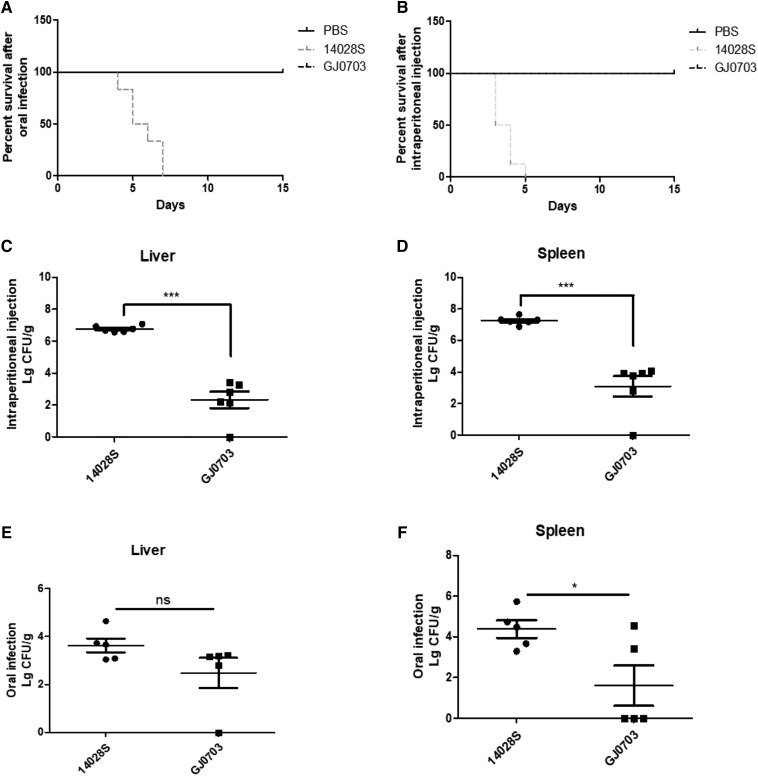
Rissen strain GJ0703 is hypovirulent in mice and causes an attenuated systemic infection. The survival of mice infected by oral gavage (A) or intraperitoneal injection (B). Bacterial burdens in livers (C) and spleens (D) of mice infected by intraperitoneal injection. Bacterial burdens in livers (E) and spleens (F) of mice infected by oral gavage. *, P < 0.05; ***, P < 0.001, (analysis of variance).